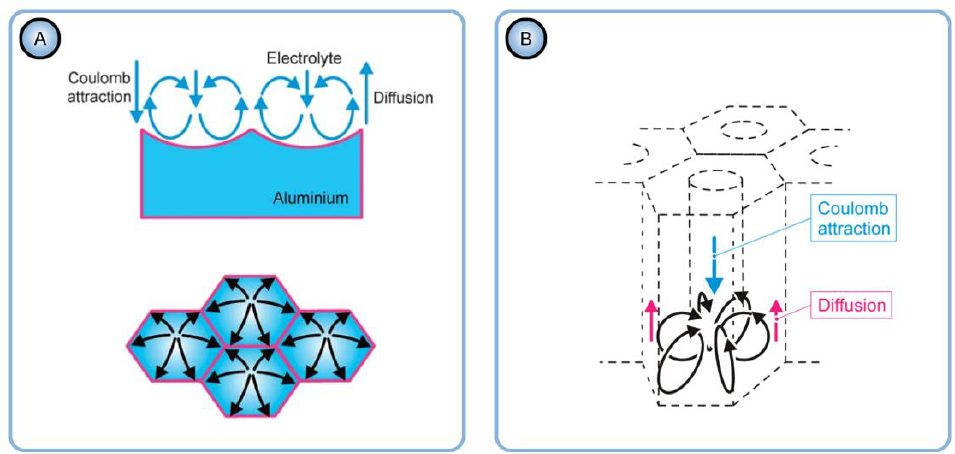
Figure 24. The principle of emergence of paired counter-rotating vortices above the Al surface and formation of a hon- eycomb-like pattern ( A ); the transport processes responsible for the continuous supply of water from hydrated electrolyte anions (the reactant) through the nanochannels, and for a stable “vertical” growth of interpore walls with regular spacing ( B ). Adapted with permissions from [16] and [17]. Copyright 2011 and 2013 The Royal Society of Chemistry.